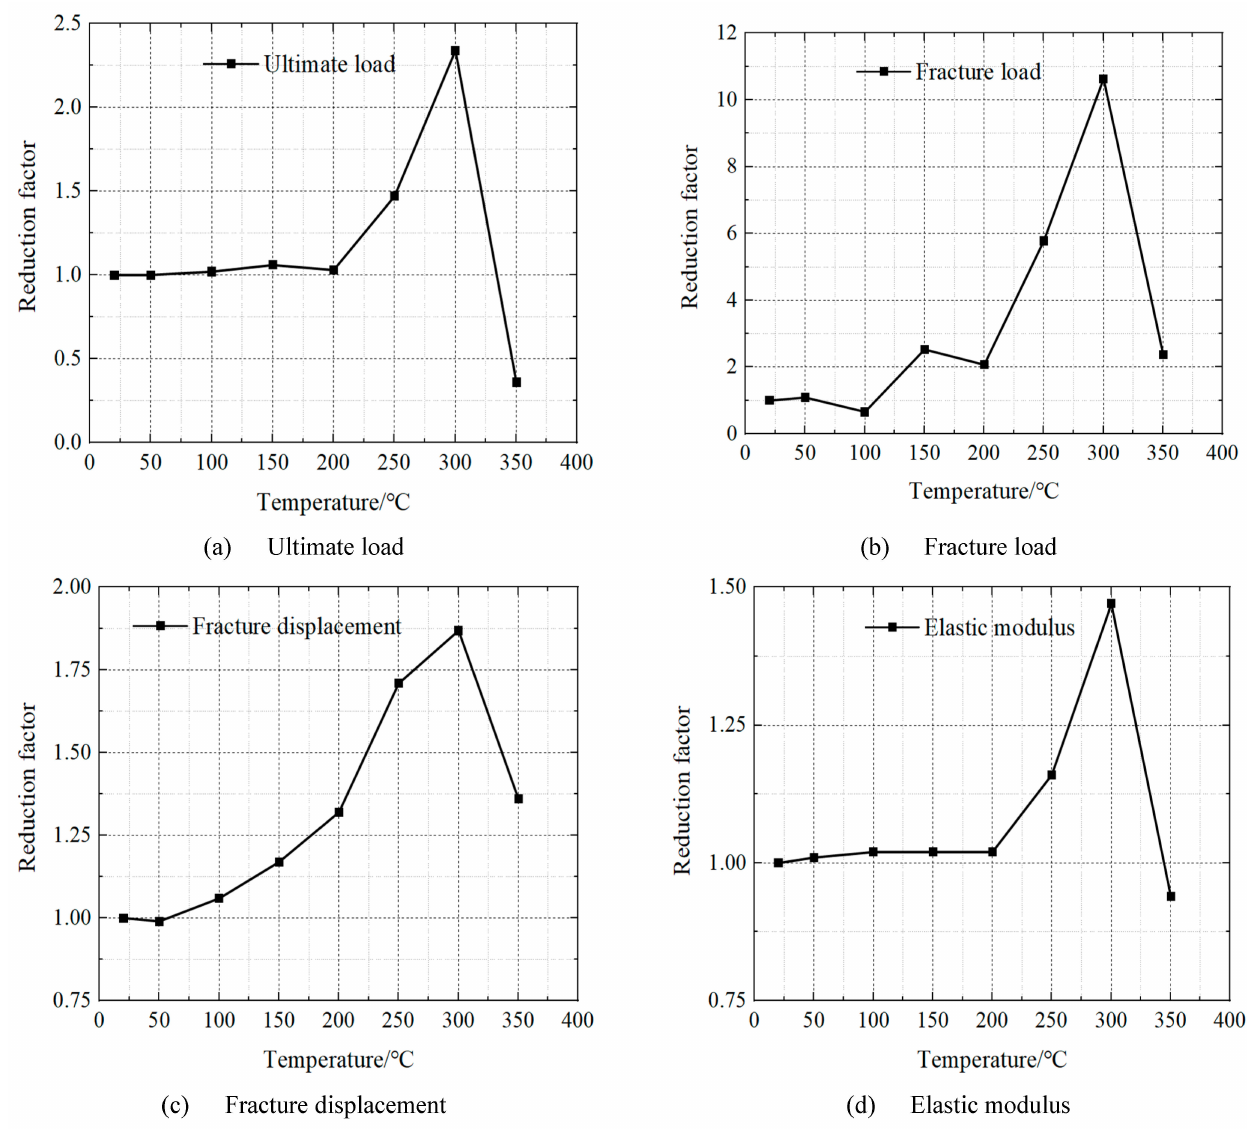
Figure 5. Residual mechanical properties of FRP composites at elevated